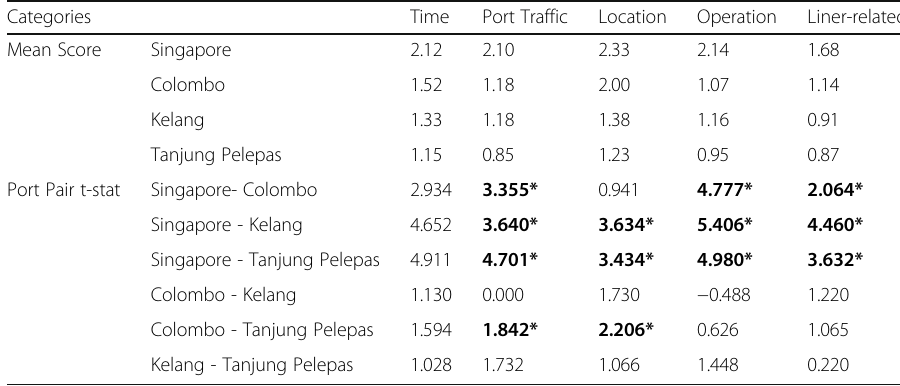
Table 11 Category-Wise Performance Comparison among Hub Ports